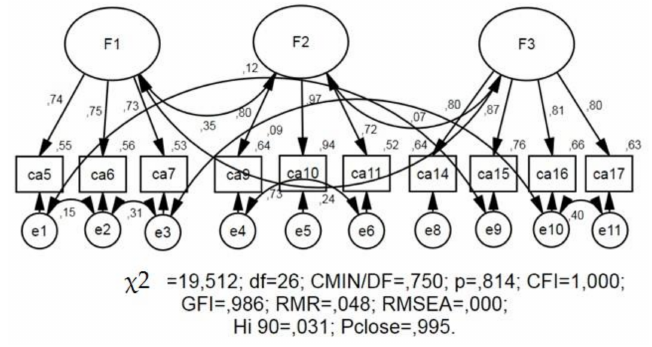
Figure 1. Confirmatory factor analysis for three-factor model of attitude toward